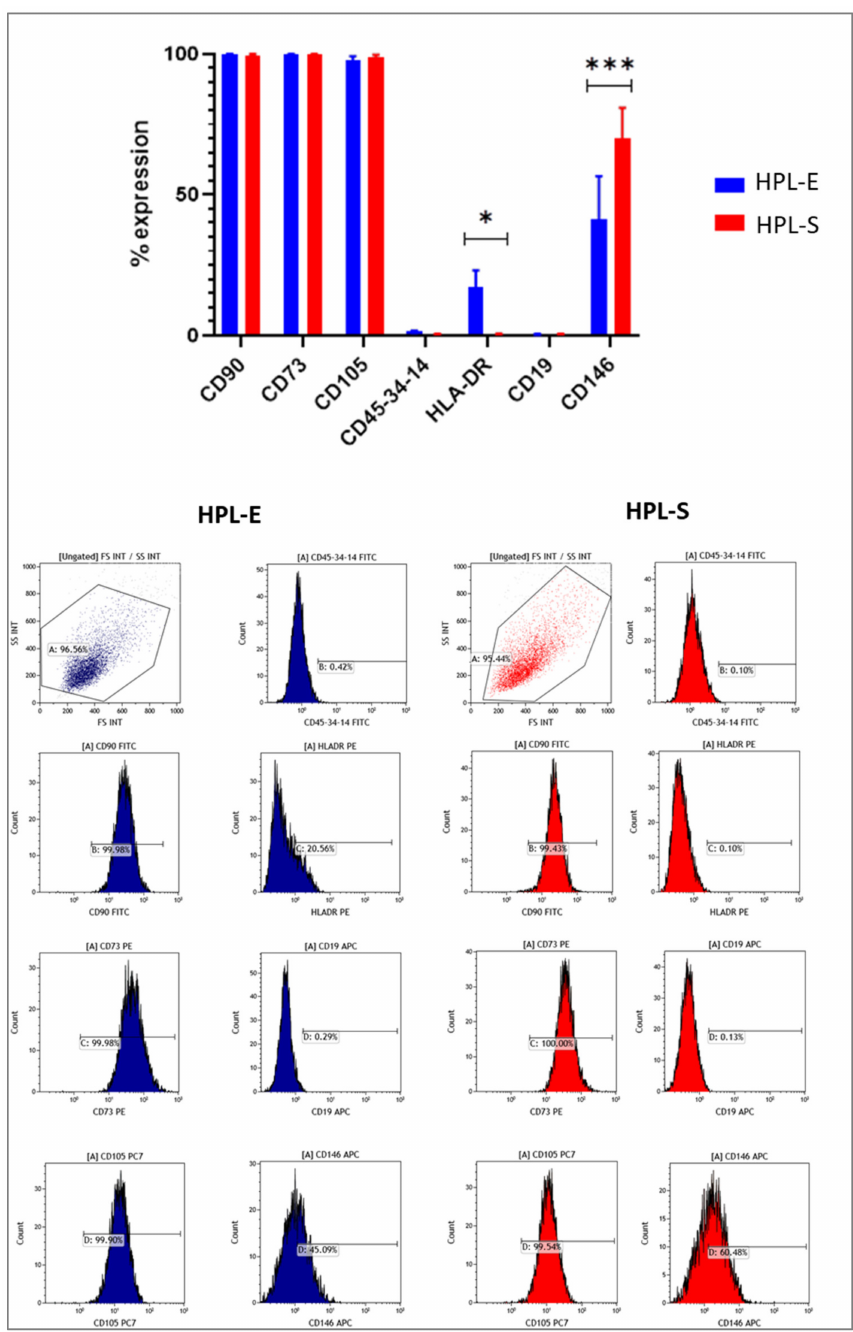
Figure 6. Immunophenotype analysis. Values are expressed as mean percentage ± SEM of positive cells for MSC antigen expression in histogram bars (top panel). Cells were analyzed at the 2nd passage for each experimental condition (n = 5), and a representative cytofluorimetric analysis is illustrated in the bottom panel. * and *** indicate, respectively, a significant ( p < 0.05) and a very highly significant ( p < 0.001)